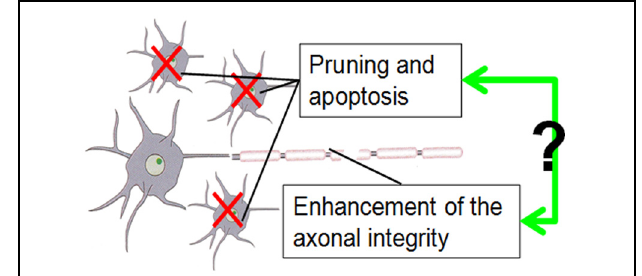
FIGURE 7 | The cartoonography demonstrates our assumption of possible interaction of apoptosis reflected by CT decrease and enhancement of axonal integrity reflected by FA increase during brain